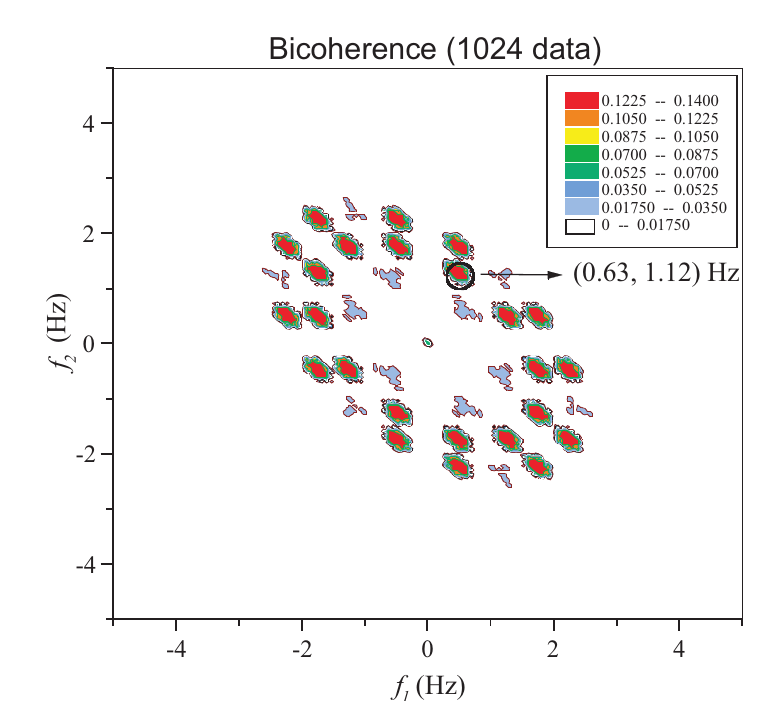
Fig. 3. Bicoherence of the function I ( t ) 2 obtained from I ( t ) defined in eq. (2.3) with a f =1.11 Hz. This is the case of a longer data set (1024 values); it shows that in this situation bicoherence gives a 2 better estimation of the quadratic frequency coupling with a smaller variance than the case of fig.